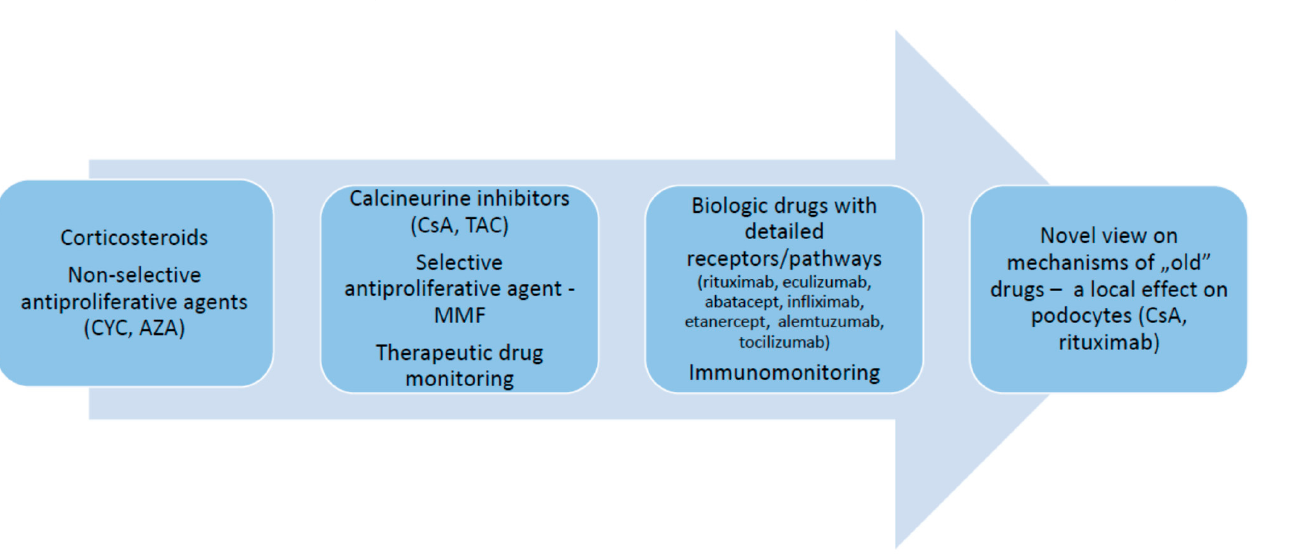
Figure 1. Evolution of therapies used in pediatric immune-mediated kidney diseases.